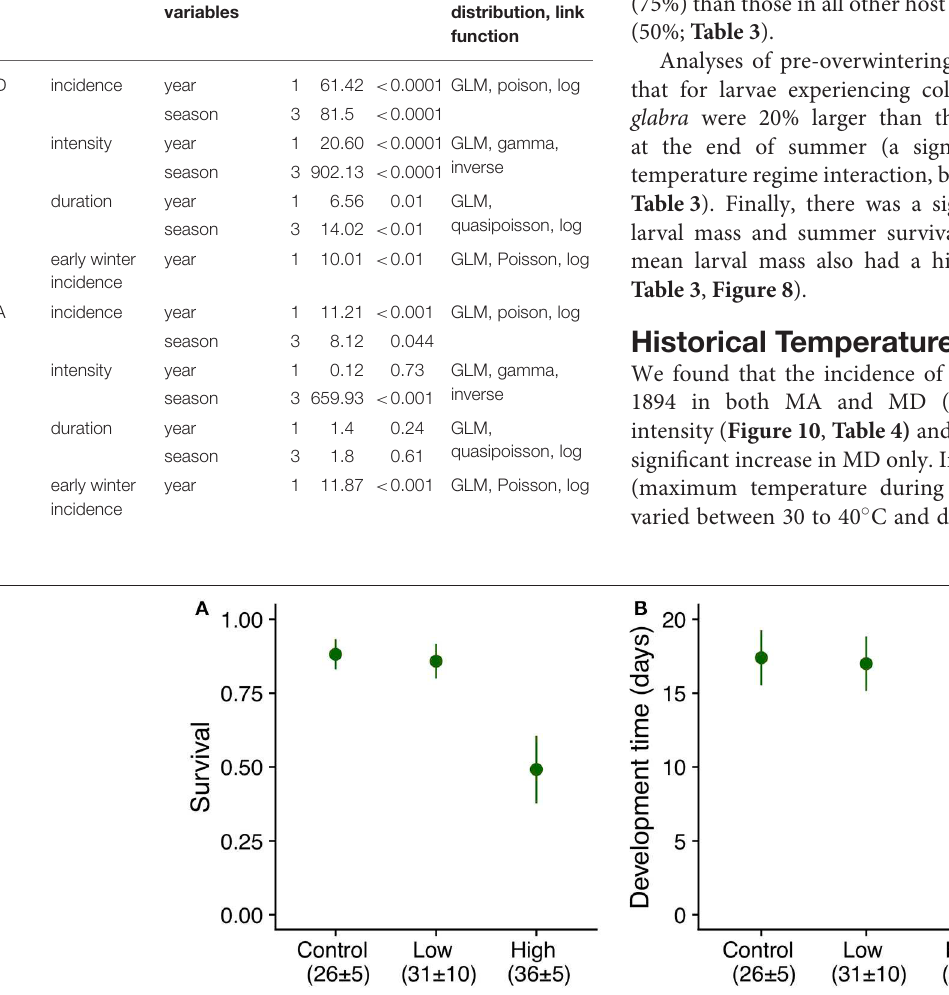
FIGURE 5 | (A) Survival (LS means ± SE) and (B) development time (LS means ± SE) from hatching to 4th instar of E. phaeton individuals exposed to summer heatwave regimes as 2nd instar (7-day old) larvae. There were significant differences among treatments in survival, but not in development time ( Table 1 ).